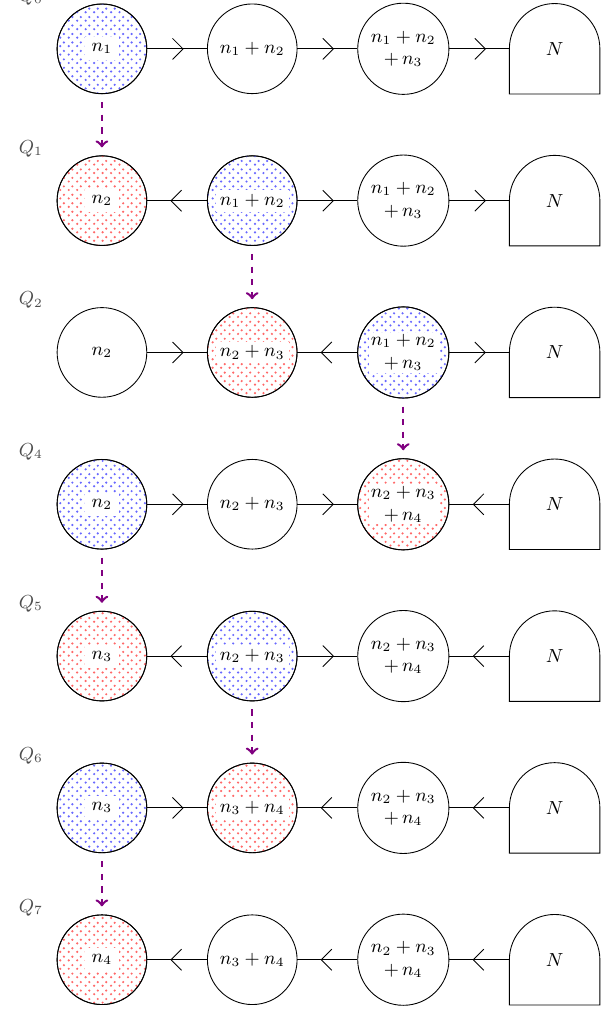
Fig. 8 A sequence of Seiberg dualities obtained by dualizing the node that has only fundamental flavours attached to it at each step. The node that is dualized is indicated by the blue arrow. The reason why in the list of names for the quivers we skipped Q 3 will become clear later